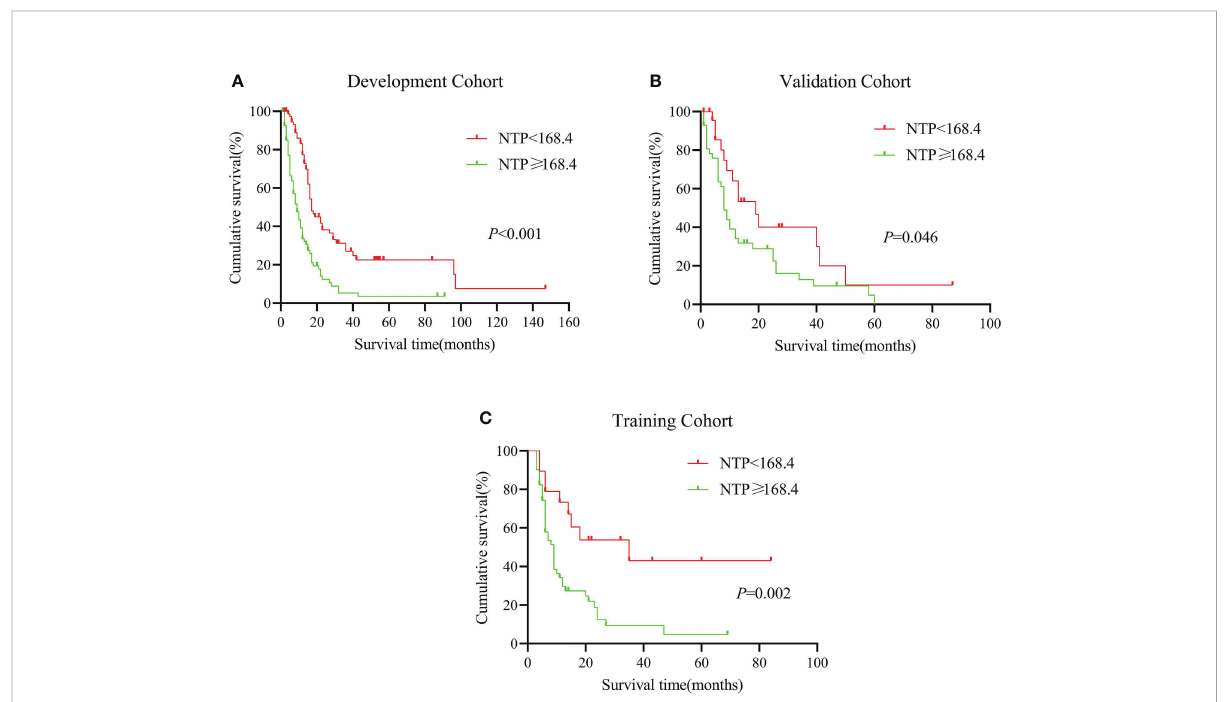
FIGURE 3 (A – C) : Kaplan-Miere analysis between different nomogram total scores predicting patients with pancreatic adenosquamous carcinoma in the (A) : development cohort, (B) : internal validation cohort, (C) : external validation